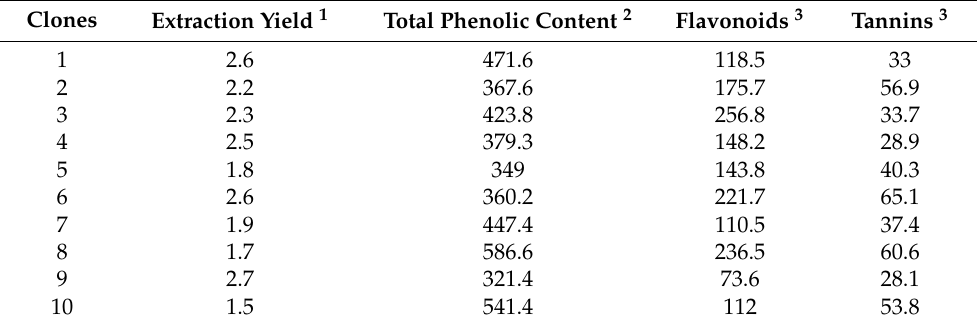
Table 2. Average values of extraction yield, phenols, tannins and wood flavonoids of ten Eucalyptus